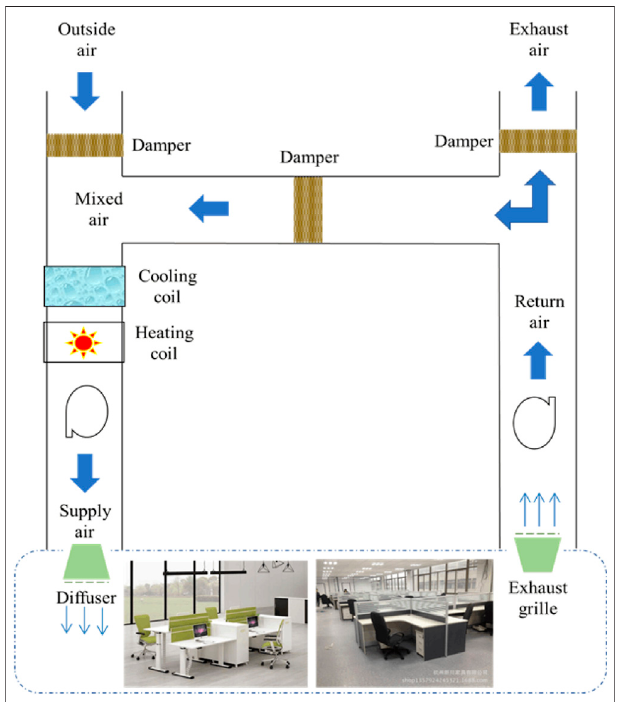
FIGURE 1 | Schematic diagram of an HVAC system.